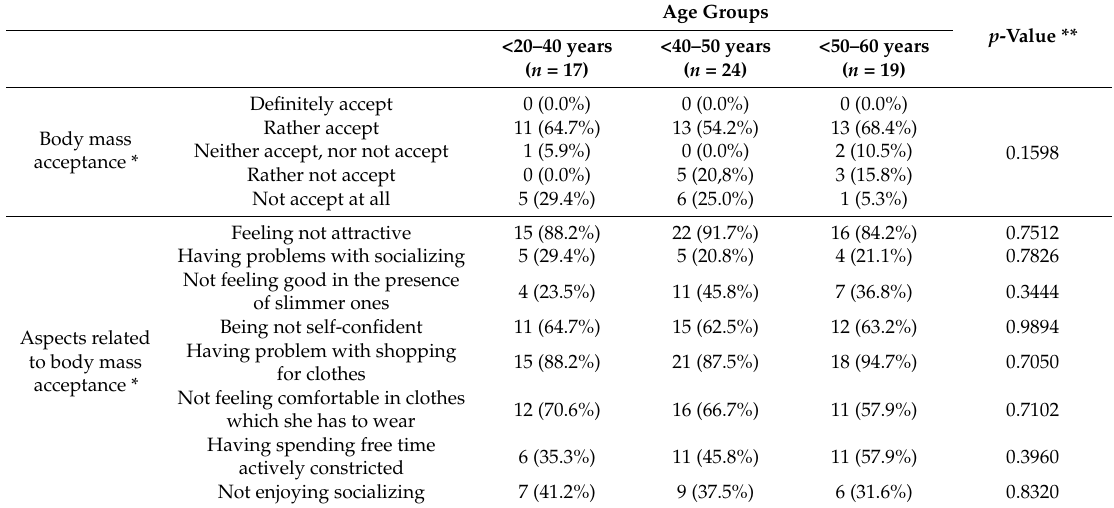
Table 3. The body mass acceptance of the studied group for the sub-groups stratified by age.